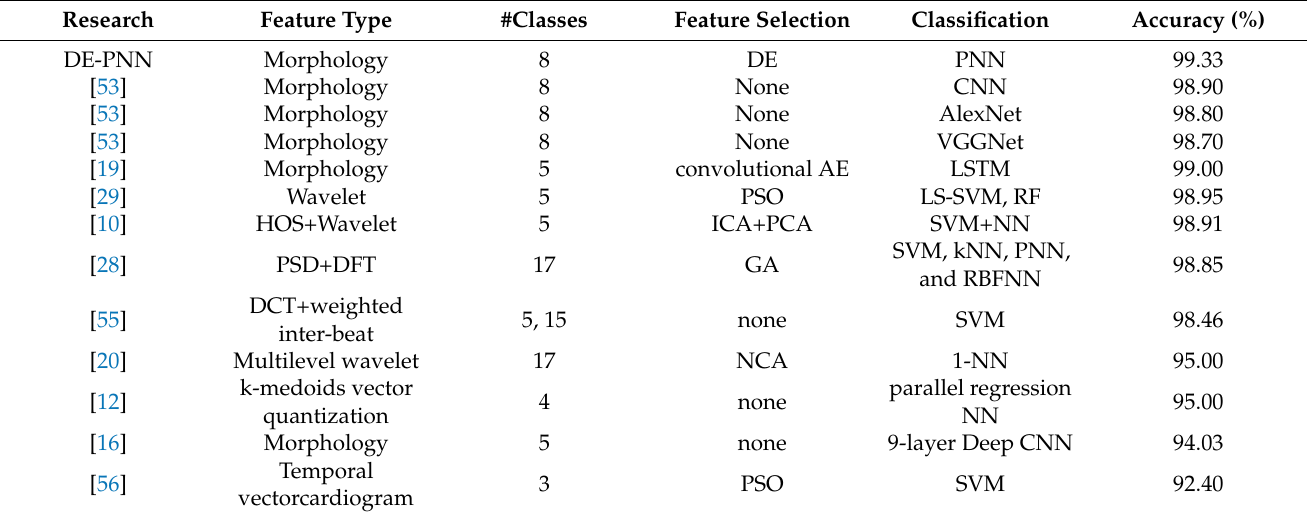
Table 6. Comparison of the proposed DE-PNN scheme with latest